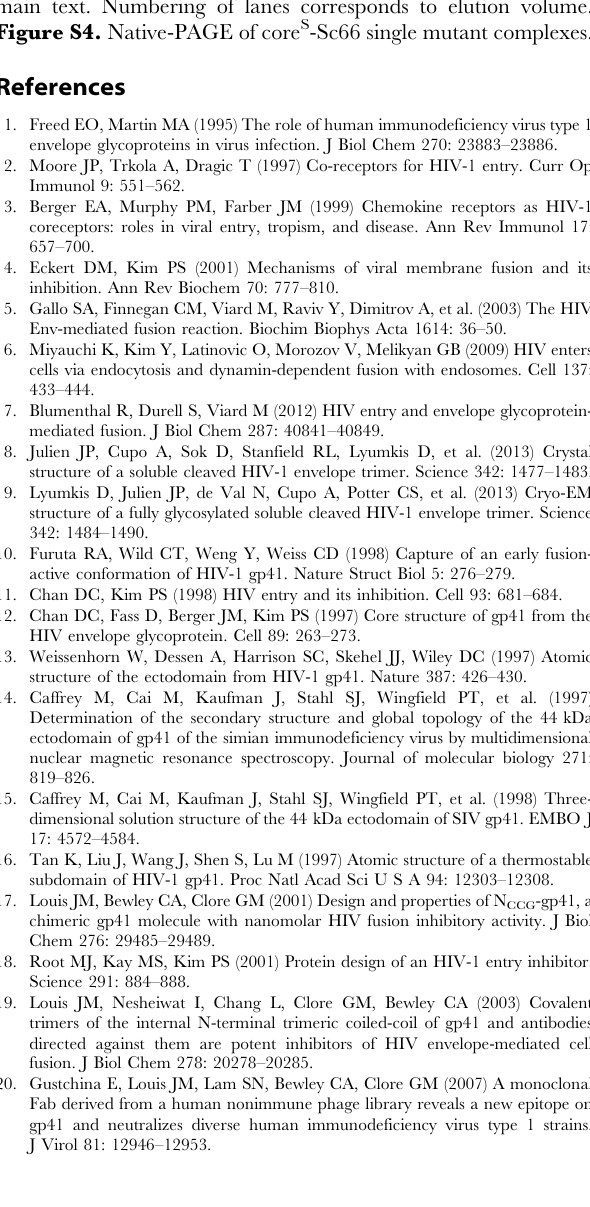
Figure S4. Native-PAGE of core S -Sc66 single mutant